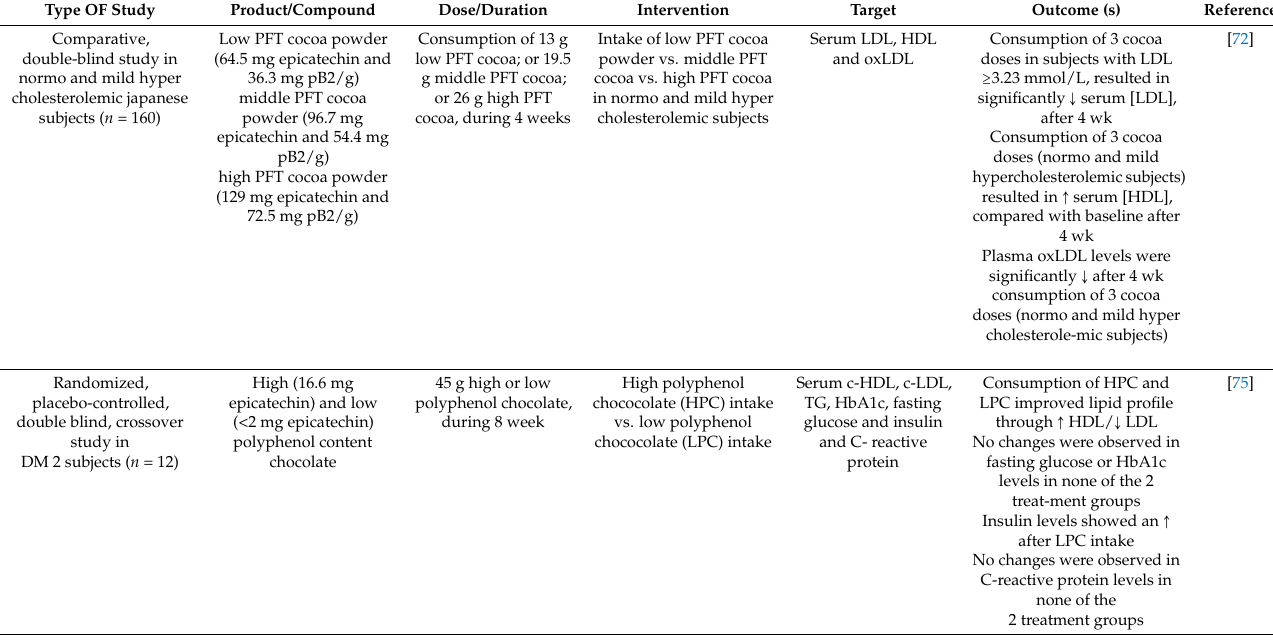
Table 3. Flavanols: hypolipidemic and hypoglycemic